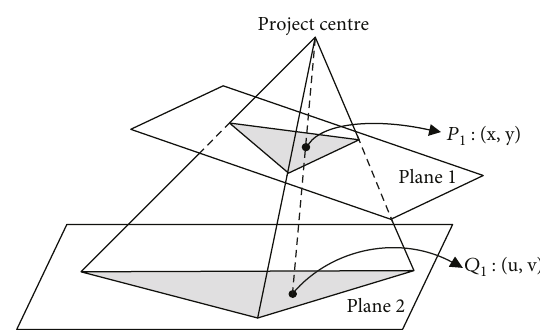
Figure 10: Perspective